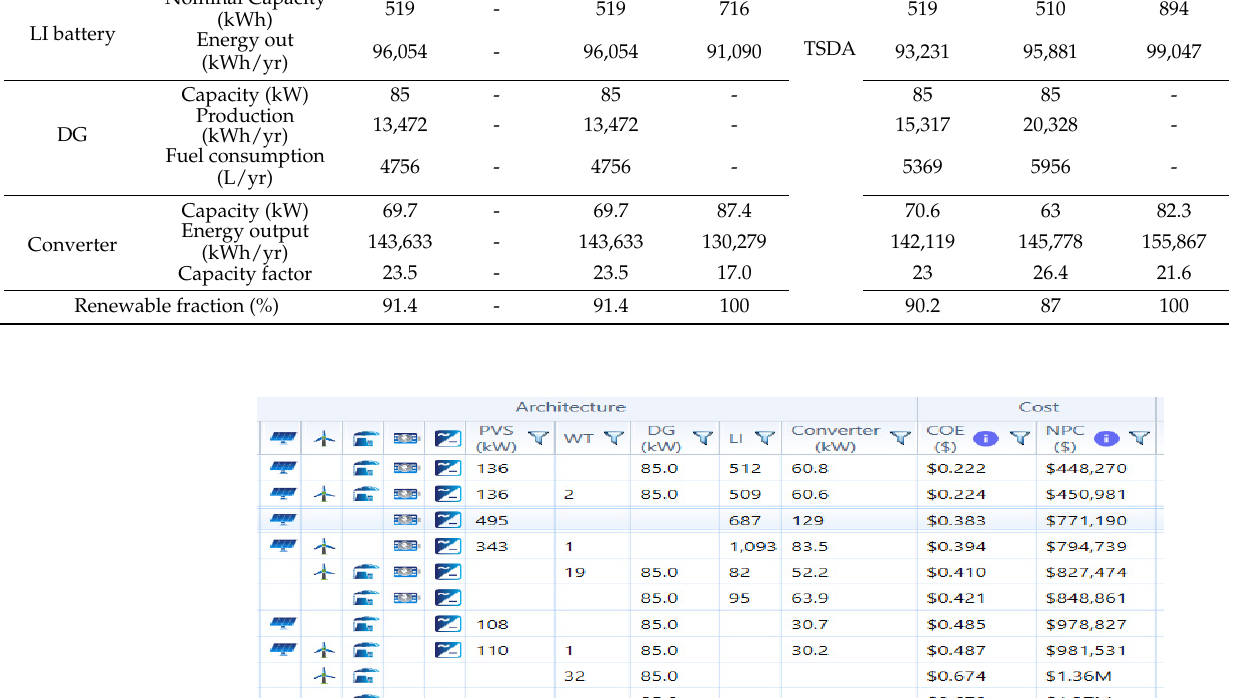
Figure 7. Comparison of different configurations for various tracking systems—PVS production growth in % when compared to FSWT.